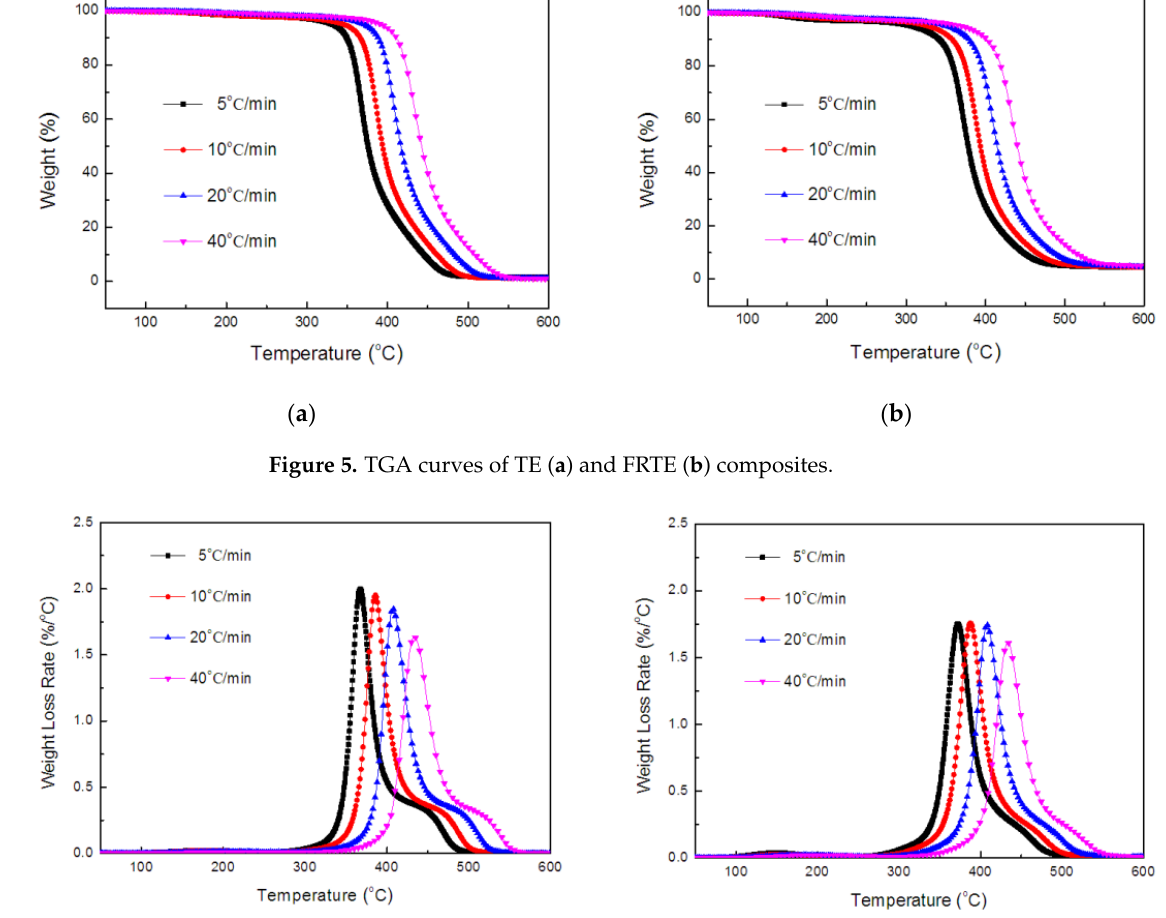
Figure 6. DTG curves of TE ( a ) and FRTE ( b ) composites.